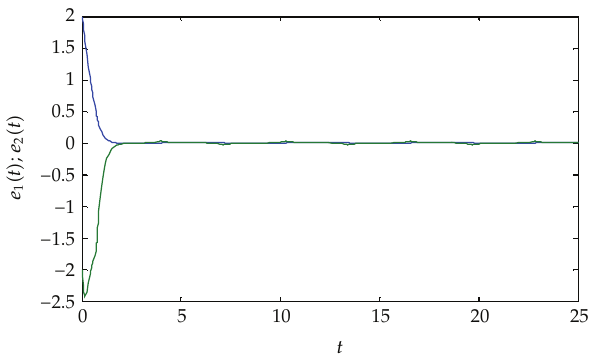
Figure 5: Synchronization errors of systems (cid:2) 3.1 (cid:3) – (cid:2) 3.7 (cid:3) with β (cid:9)